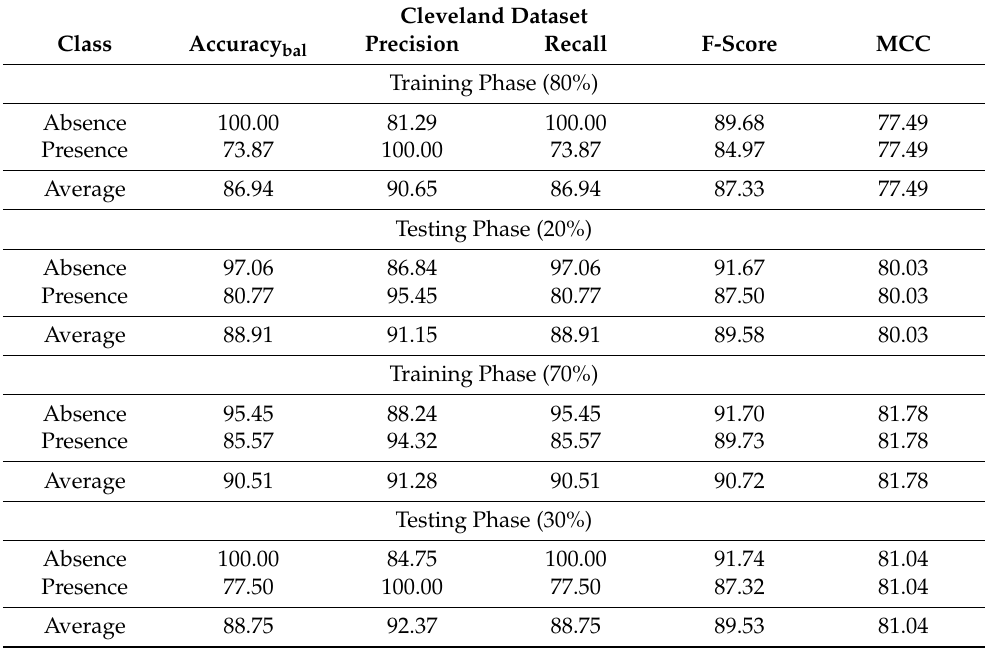
Table 2. Analytical results of the MLMDMC-ED algorithm under distinct measures on the Cleveland